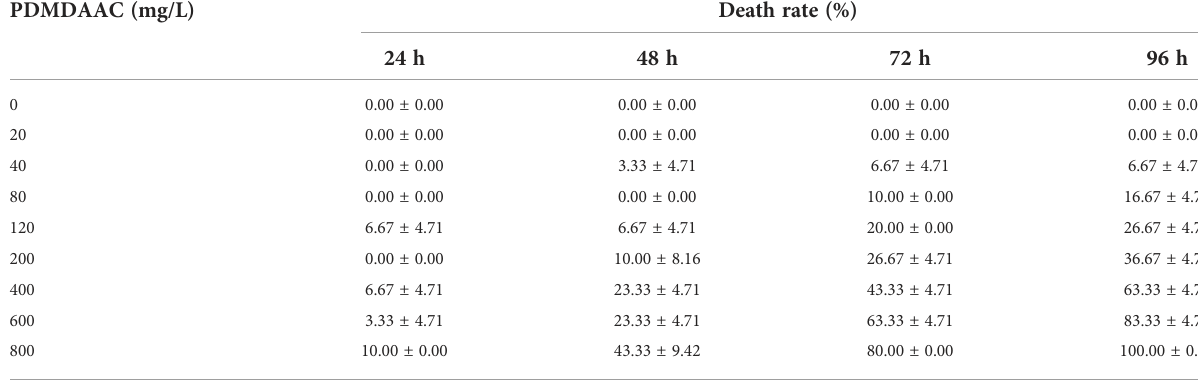
TABLE 1 96h acute toxicity test results of Poly dimethyl diallyl ammonium chloride (PDMDAAC) on juveniles of P. vannamei . PDMDAAC